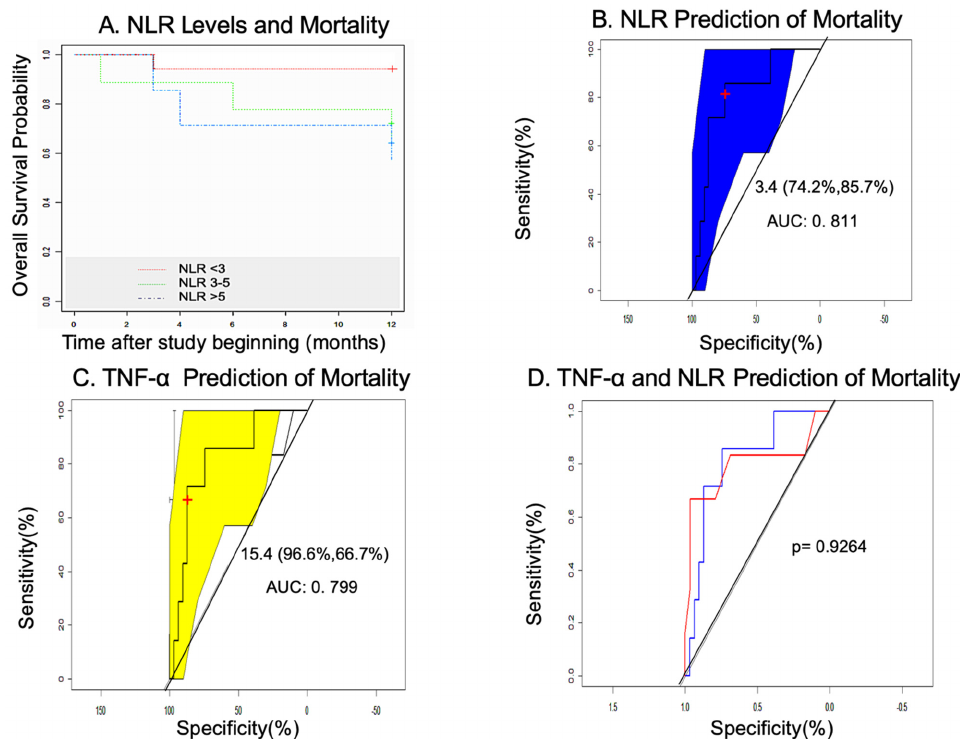
Figure 8. Relationship between NLR and plasma TNF- α with mortality. ( A ). Kaplan-Meier analy- sis of NLR and mortality. ( B ). AUC-ROC (Area Under the Curve-Receiver Operating Characteristics) curve of NLR related to mortality. ( C ). AUC-ROC curve of plasma TNF- α related to mortality. Color blue and yellow represent confidence intervals. Values in brackets represents sensitivity and specificity, respectively ( D ). Comparation between plasma TNF- α and NLR as predictors of mortality showed no significant differences ( p = 0.9264). (2 months) ( p = 0.008, OR). In addition, the level of NLR at baseline was closely related to the level of hsCRP (r = 0.5335, p = 0.0006) (Figure 9A), especially for the values of hsCRP ≥ 0.5 and NLR > 2.5 ( p = 0.013) (Figure 9B).